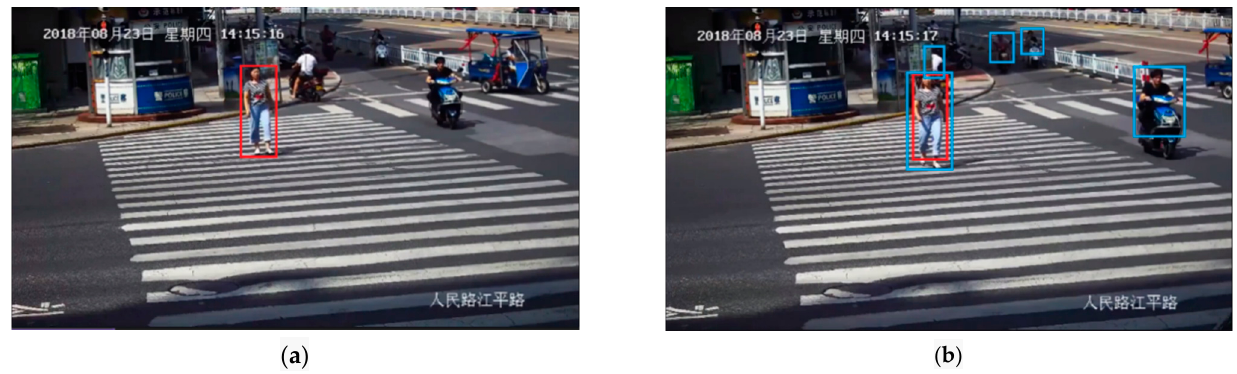
Figure 3. Schematic diagram of variable kcf scale. ( a ) Pedestrian tracked with the KCF; ( b ) KCF scale problem corrected by YOLOv3.